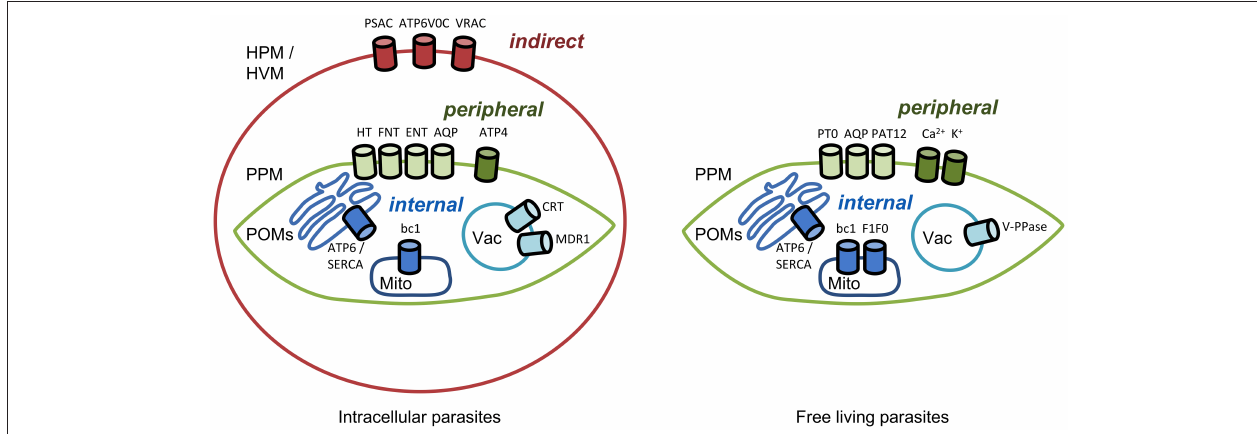
FIGURE 1 | Channels and transporters of parasites as targets for indirect , peripheral , and internal therapeutic attacks. HPM, host plasma membrane; HVM, host vacuolar membrane; PPM, parasite plasma membrane; POMs, parasite organelle membranes; Mito, mitochondrion; Vac, vacuole. Abbreviations of the channel and transporter proteins are explained in the